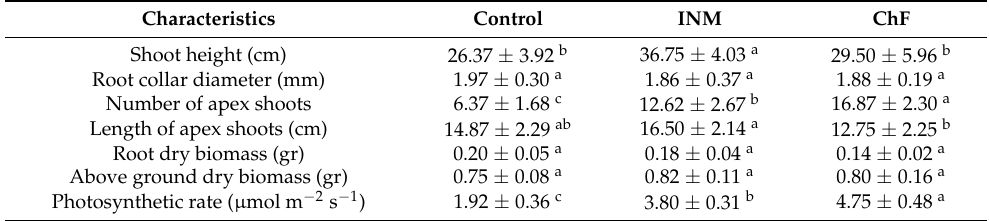
Table 3. Effect of integrated nutrient management fertilizers (INM) and chemical fertilizers (ChF) on characteristics related with growth and physiology of Teucrium luteum subsp. gabesianum seedlings. Means ± standard deviation values are shown. Values in the same row followed by the same letter are not significantly different ( p > 0.05), according to Duncan’s test.